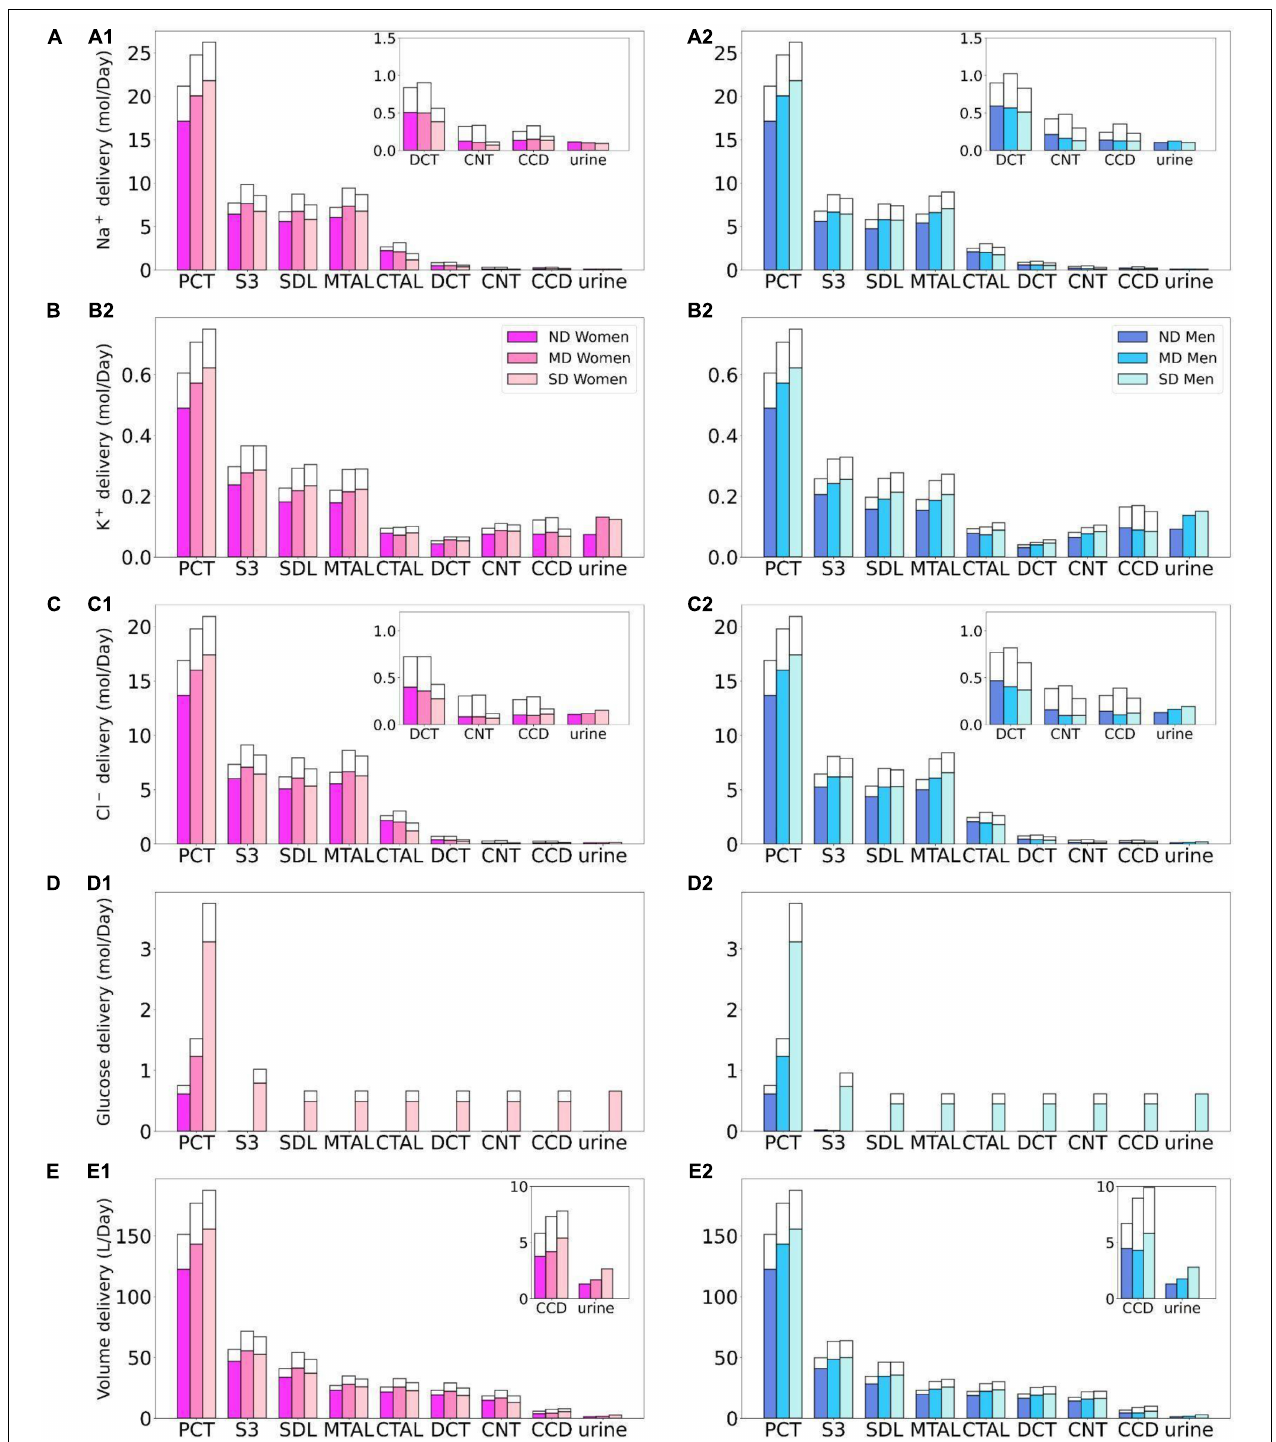
FIGURE 2 | Delivery of Na + (A) , K + (B) , Cl – (C) , glucose (D) , and fluid (E) to the beginning of individual nephron segments in women and men without diabetes (ND) and with moderate (MD) and severe diabetes (SD). Color bars, superficial nephron values; white bars, juxtamedullary values, computed as weighted totals of the five representative model juxtamedullary nephrons. The models assume that superficial nephrons account for 85% of the nephron population; thus, the superficial delivery values are substantially higher. In each case, only one bar is shown for “urine” since the superficial and juxtamedullary nephrons have merged at the cortical collecting duct entrance. PCT, proximal convoluted tubule; SDL, descending limb; MTAL/CTAL, medullary/cortical thick ascending limb; DCT, distal convoluted tubule; CNT, connecting tubule; CCD, cortical collecting duct.